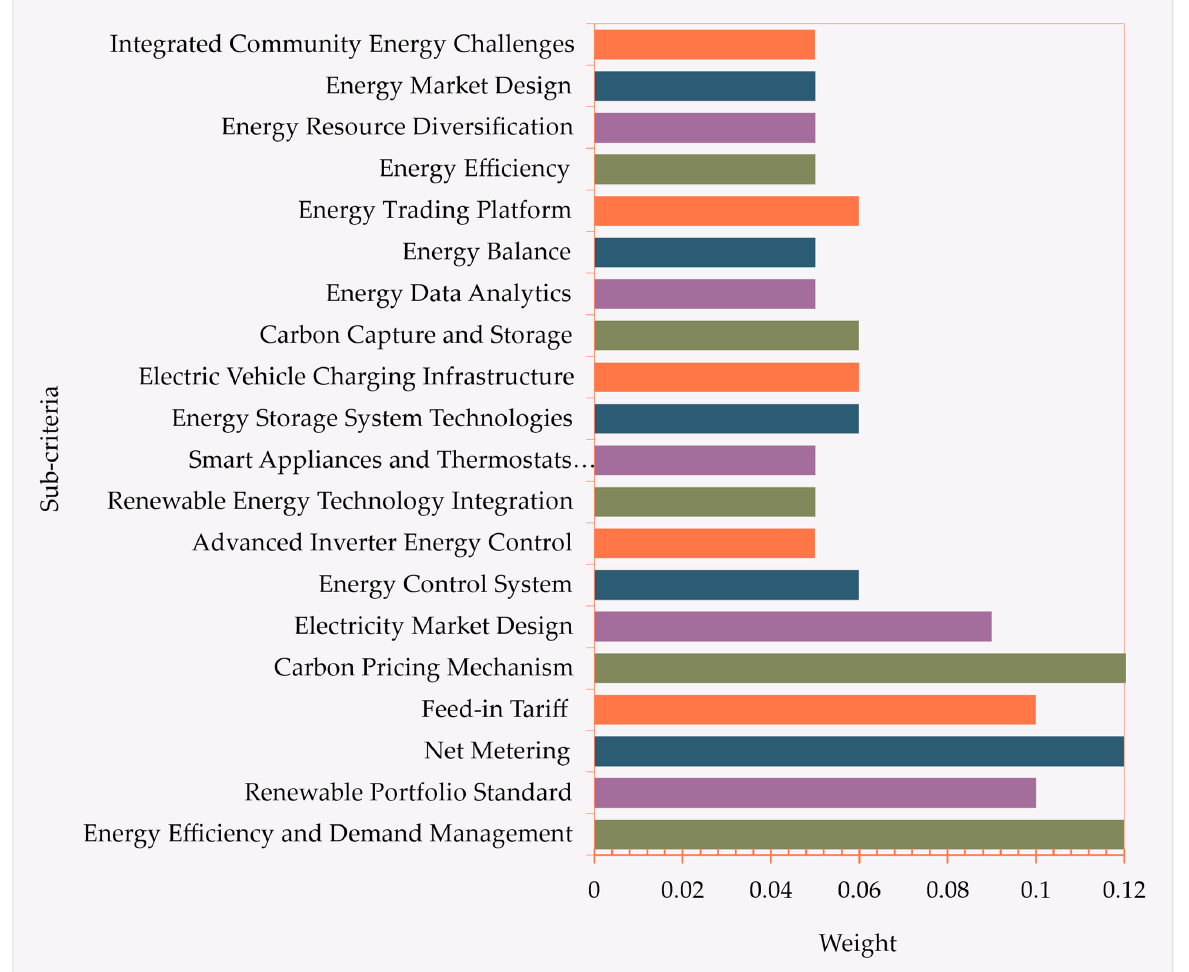
Figure 9. Overall sub-criteria weights (consolidated view of sub-criteria importance, calculated by multiplying criteria weights and sub-criteria weights).